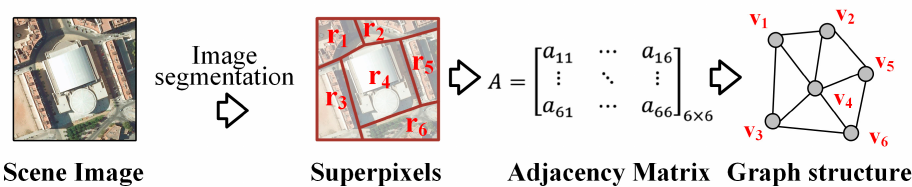
Figure 3. Illustration of the graph structure construction procedure for an RS